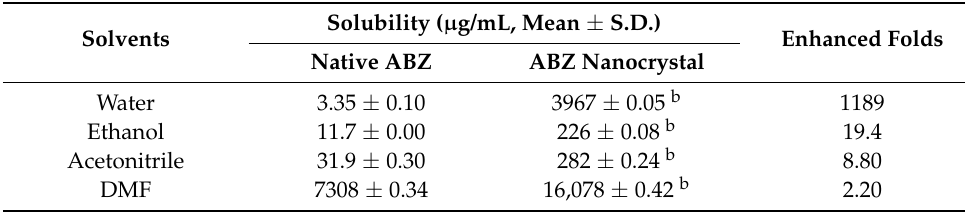
Table 2. Solubility of native ABZ and ABZ nanocrystal in various solvents (25 ◦ C, standard atmo- spheric pressure).